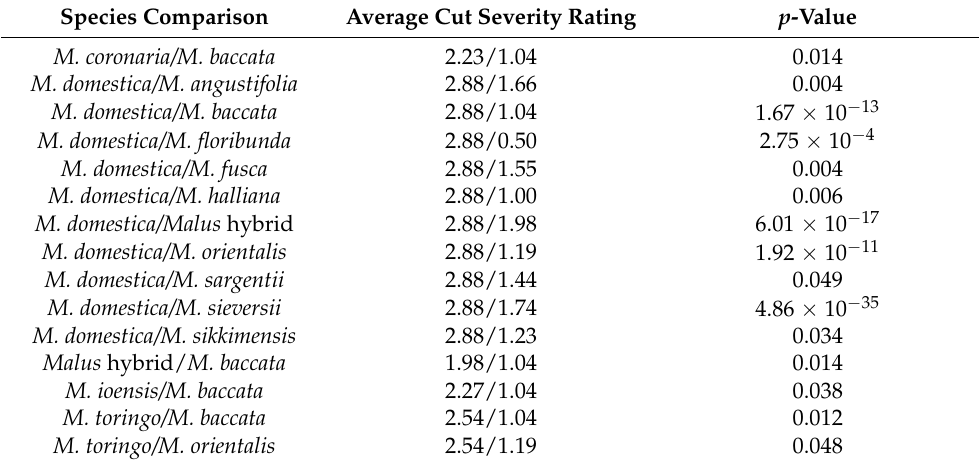
Table 2. Significant pairwise comparisons of cut severity ratings in the main collection between species with more than 10 trees. For each comparison, the species with the higher average cut severity rating is listed